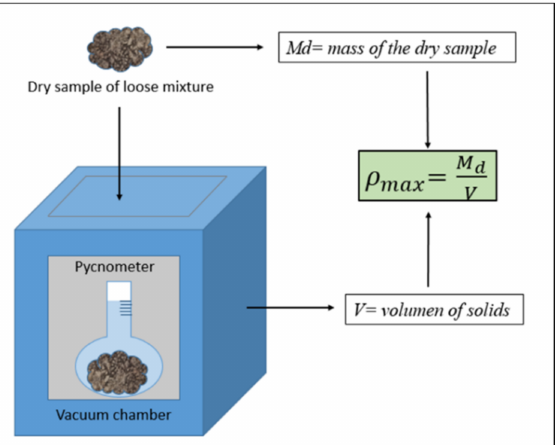
Figure 1. Scheme of the calculation of maximum density, ρ max . Valid for Proctor and gyratory proce-